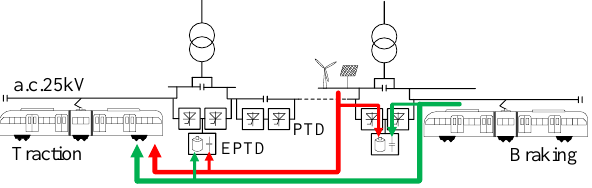
Figure 2. Energy-storage-based smart electrical infrastructure.